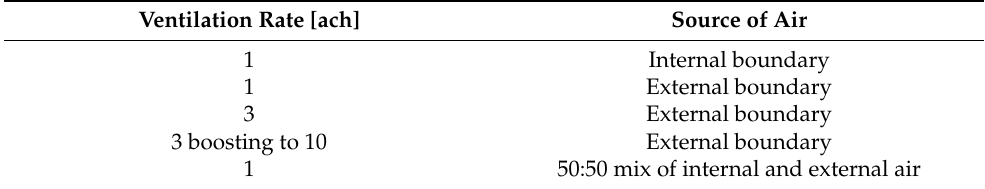
Table 1. Ventilation rates and source of roof cavity air used in the WUFI ® 2D